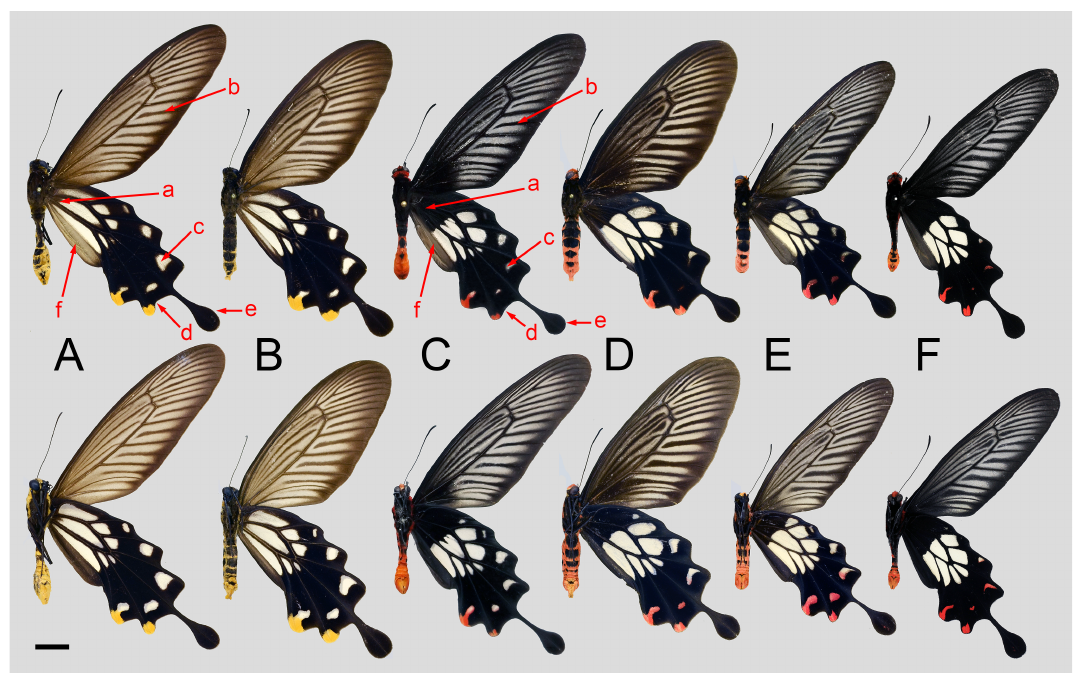
Figure 3. Morphological comparison of Losaria coon and L. doubledayi A: L. coon coon , West Java,